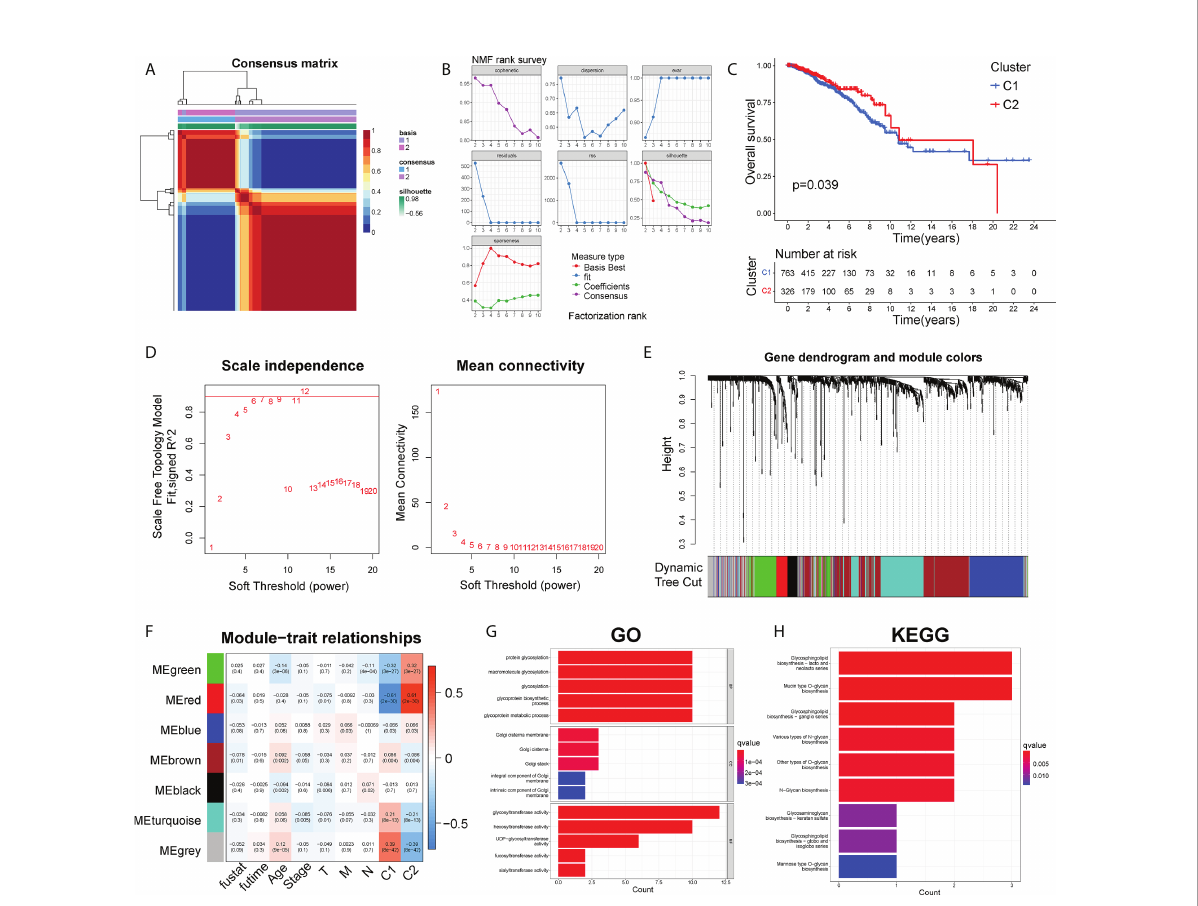
FIGURE 1 The NMF and WGCNA analysis to identify functional module. (A) Consensus map of NMF clustering. (B) The cophenetic, rss, and dispersion distributions. (C) The Kaplan-Meier curves about OS of C1 and C2 clusters. (D) . Cluster analysis of the samples. (E) Gene dendrogram and module colors. (F) Correlations of modules with clinical phenotypes. (G) Top 10 results for GO enrichment of genes in the grey module. (H) Top 10 results of KEGG enrichment of genes in the grey